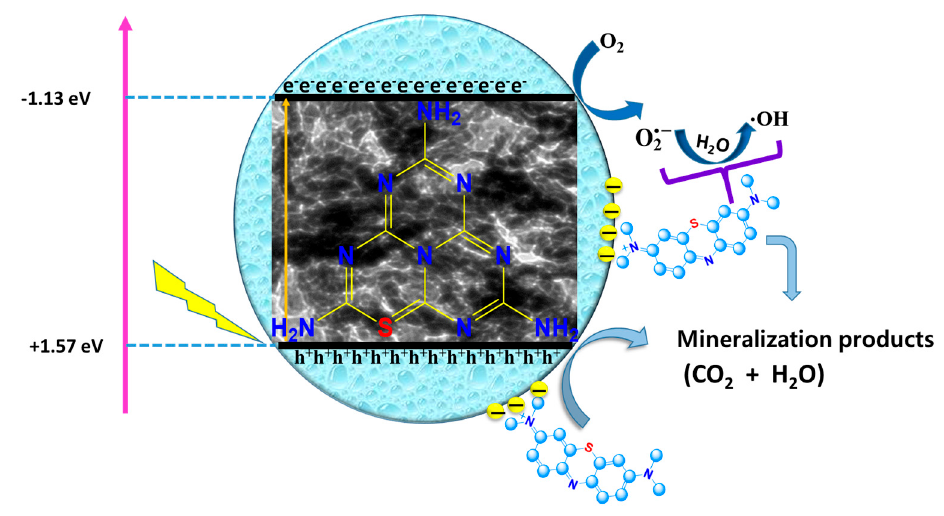
Scheme 2. Schematic illustration of a plausible mechanism of SCNPNS toward photocatalytic degradation of MB dyes under visible light